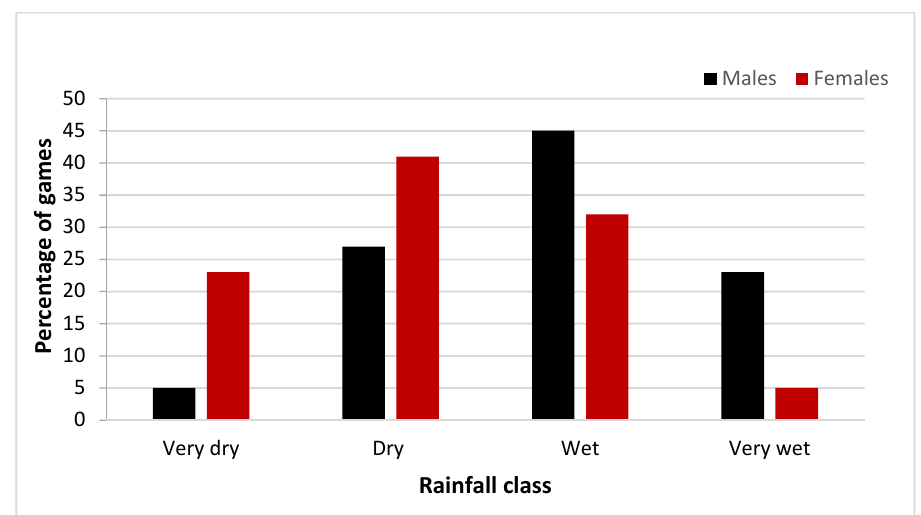
Figure 6. Percentage of games in annual rainfall categories among male- and female-headed house- hold grazing game players in UER (n female games = 22; n male games = 22).